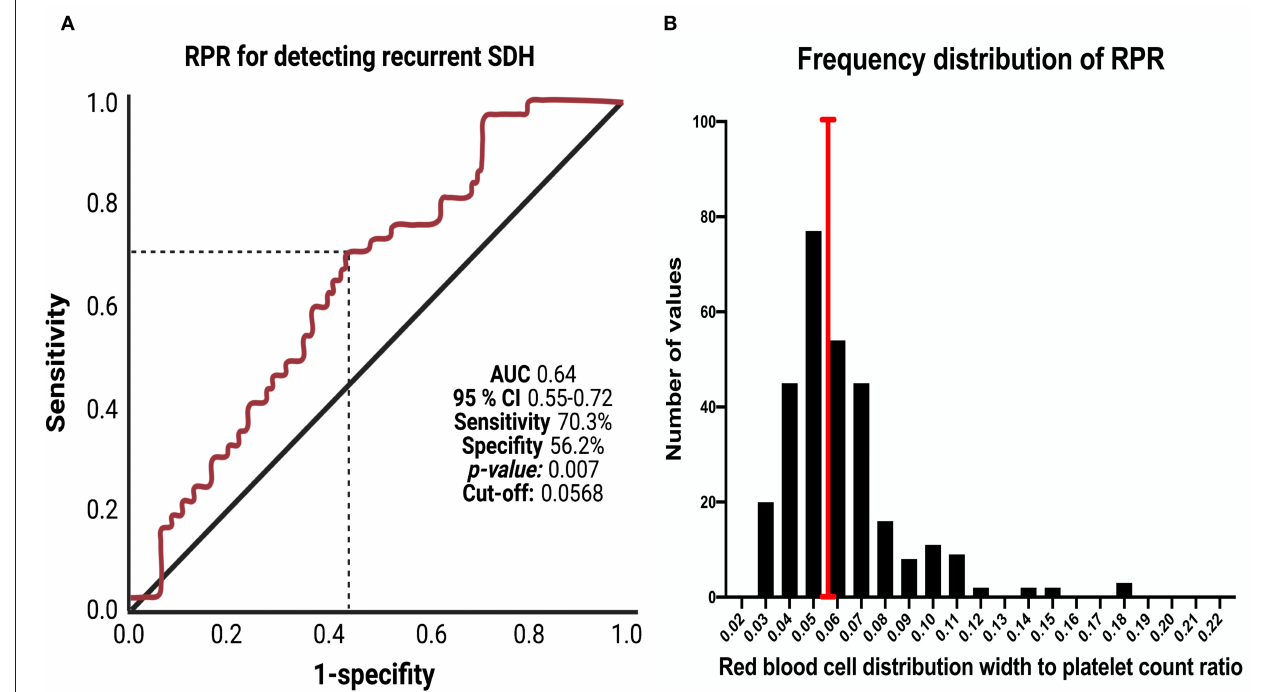
FIGURE 1 | (A) Receiver-operating characteristic curve illustrating the ability of baseline RPR to predict recurrence of cSDH. The area under the ROC curve (AUC) of baseline RPR for recurrent cSDH was 0.64 (95% confidence interval (CI): 0.55–0.72). Sensitivity and specificity of baseline RPR for predicting recurrent cSDH were 70.3% and 56.2%, respectively, with a threshold of ≥ 0.0568. (B) Frequency distribution histogram for baseline RPR in the investigated cohort. The black bars indicate the number of patients with the corresponding RPR values. The red vertical line displays the optimized cut-off point for baseline